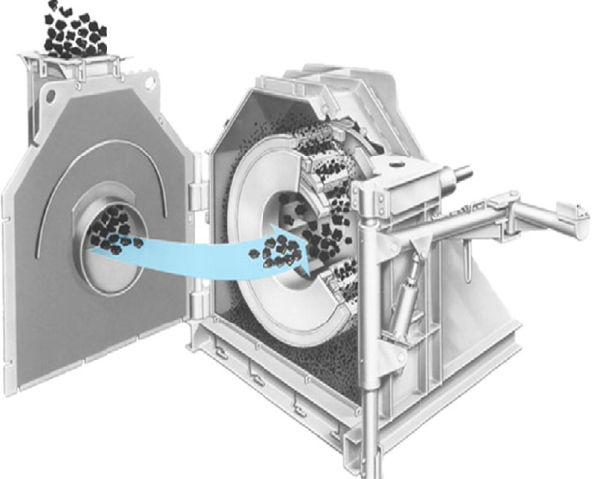
Fig. 1. Schematic of a cage mill and two cages